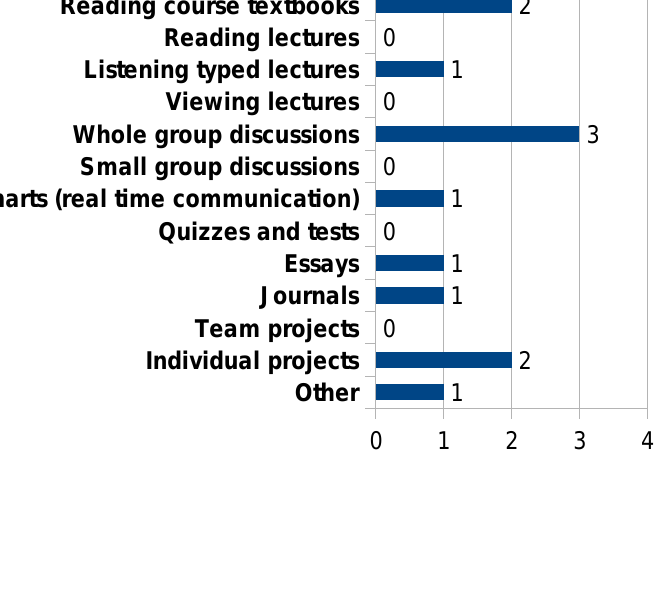
Figure 3 . Question 8 results.